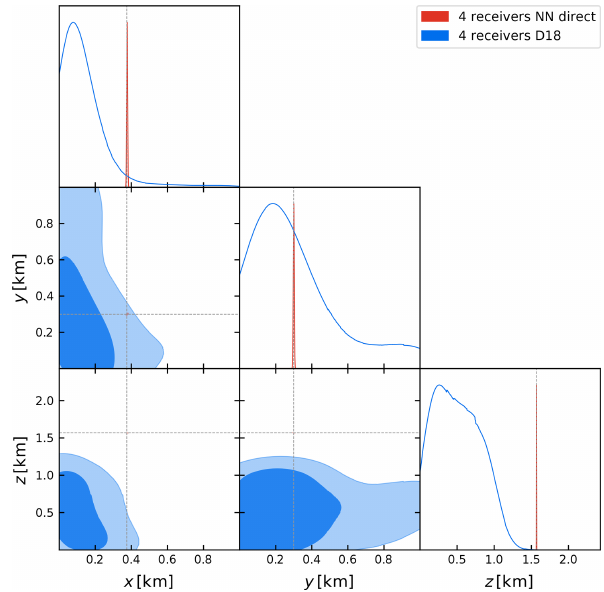
Figure 10. Comparison of the marginalized 68% and 95% credi- bility contours obtained with the D18 method (in blue) and our pro- posed NN direct generative model (in red) described in Sect. 2.2.1, considering a seismic trace measured by the four receivers shown in Fig. 9. The dashed lines black indicate the source’s true coordinates at ( x,y,z ) = (0.375km, 0.3km,